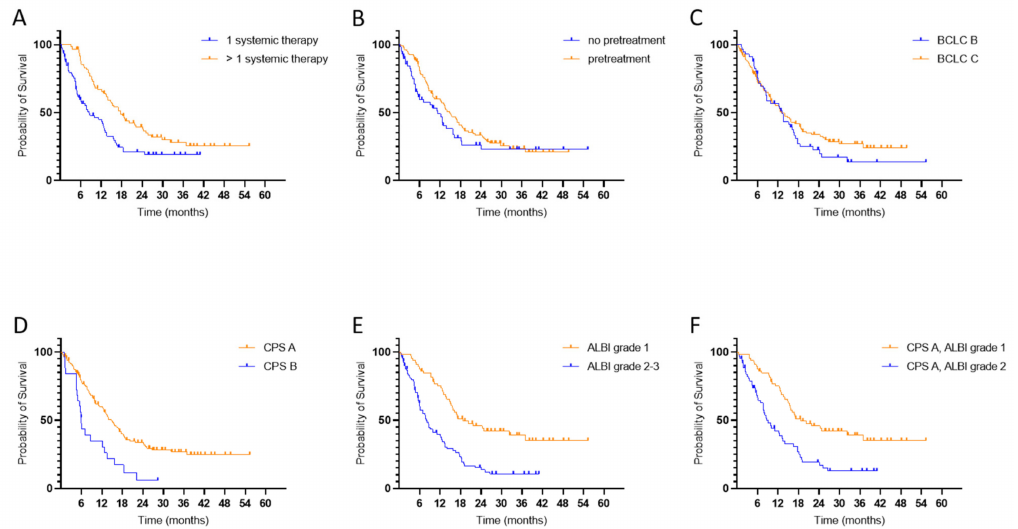
Figure 3. Kaplan-Meier curve of the median overall survival (mOS). ( A ) 1 therapy line vs. >1 therapy line (mOS 1 therapy line 258 days; mOS >1 therapy line 537 days; p value 0.0007); ( B ) prior locoregional therapy (mOS no pretreated patients 343 days; mOS pretreated patients 451 days; p value ns); ( C ) BCLC B vs. BCLC C (mOS BCLC B 404 days; mOS BCLC C 398 days; p value ns); ( D ) patients with CPS A vs. patients with CPS B at baseline (mOS CPS A 451 days; mOS CPS